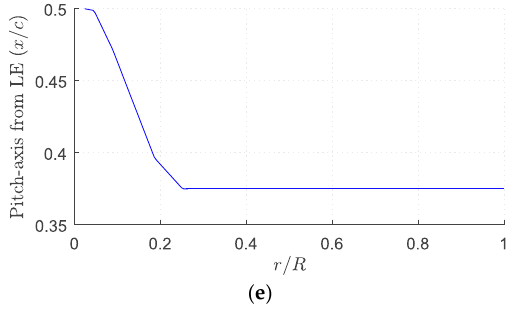
Figure 6. Final blade design results for the OffWindChina 5 MW rotor with a radius of 65 m. ( a ) Chord; ( b ) twist; ( c ) relative thickness; ( d ) thickness; and ( e ) pitch-axis from LE. The pitch axis, x , is defined from the leading edge (LE) and is relative to the chord length, c .